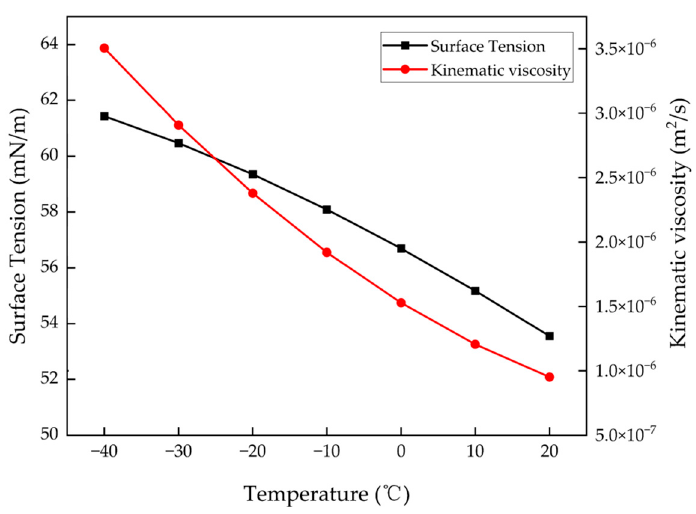
Figure 2. Surface tension and kinematic viscosity curves of MMH.